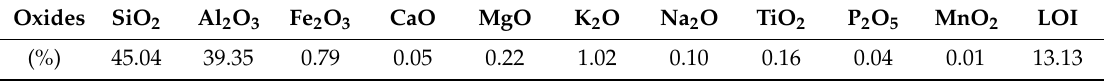
Table 1. Chemical composition of major elements from Burela kaolin.